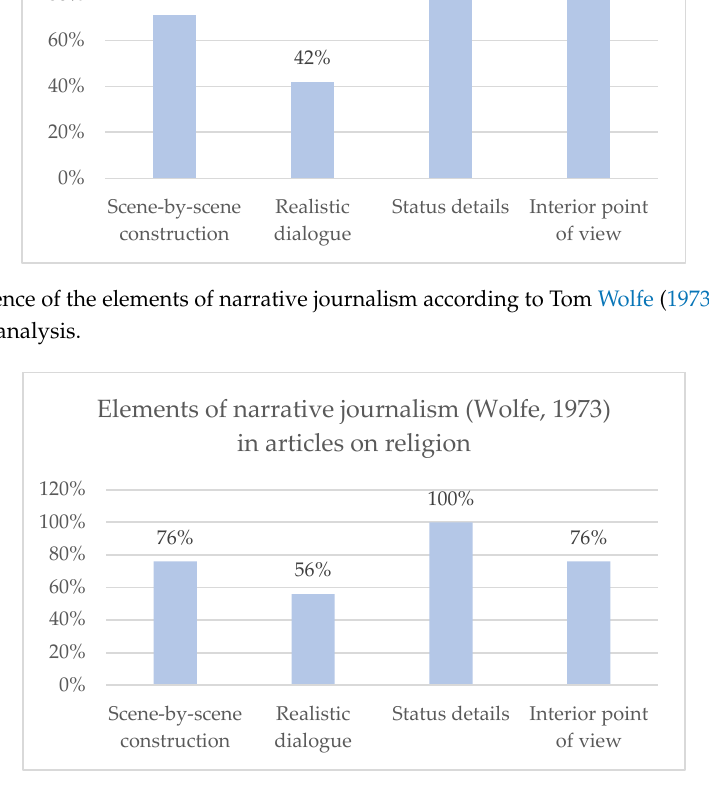
Figure 3. Presence of faiths in the articles analysed in Jot Down, Gatopardo, and The New Yorker .